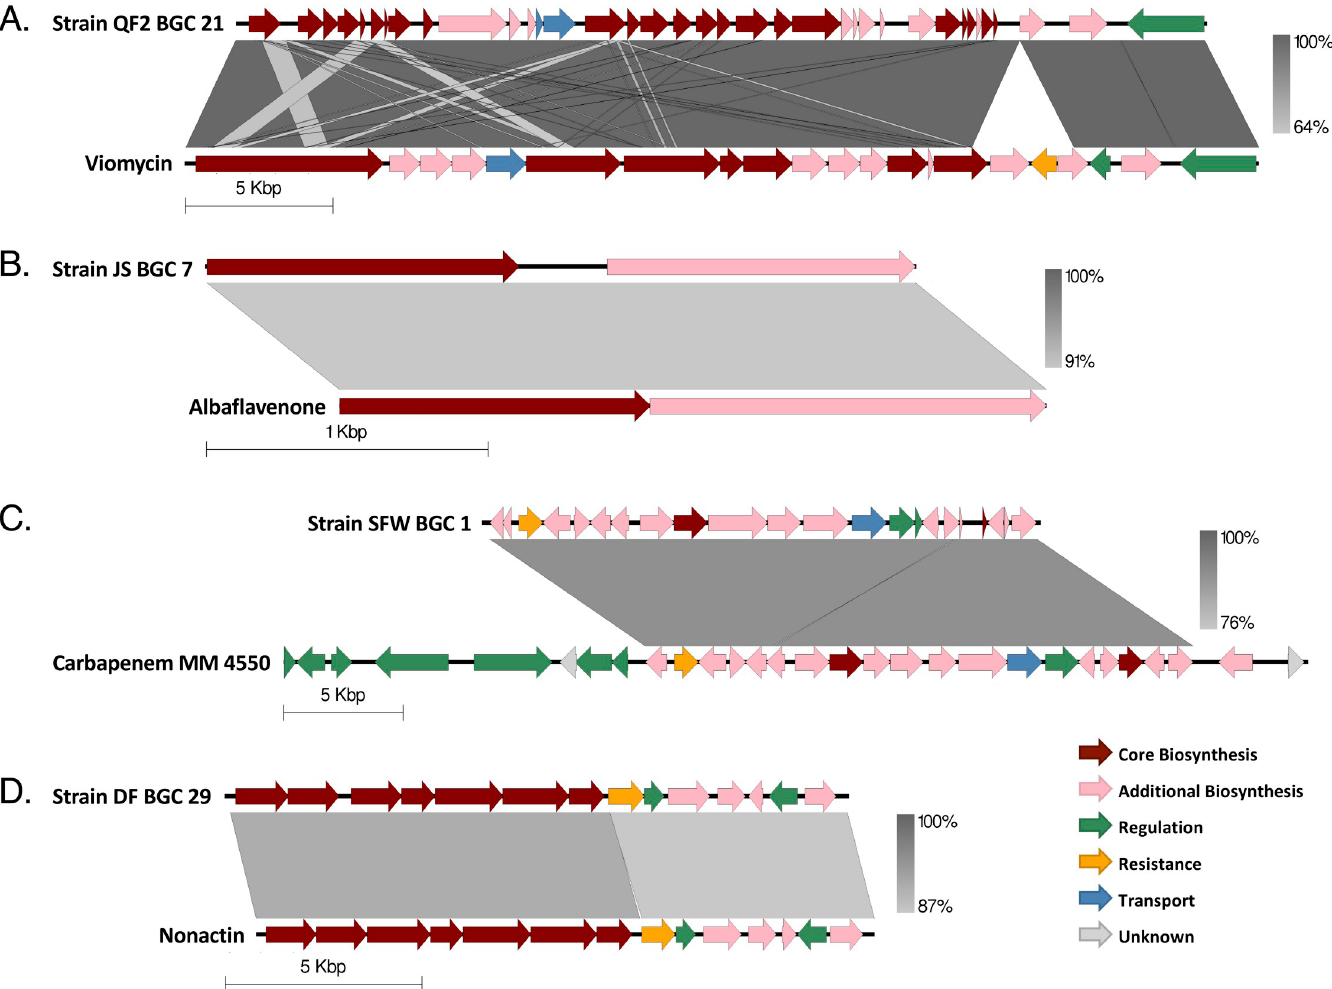
Fig 5. Comparison of BGCs encoded in the genomes of bacterial soil isolates and the predicted most similar, previously characterized BGC with an antibacterial product. ( A ) Strain QF2, BGC 21, compared to the BGC previously described to produce the antibiotic viomycin (NCBI Acc No. AY263398.1), encoded in the WGS of S . vinaceus ATCC 11861. ( B ) Strain JS, BGC 7, compared to the BGC previously described to produce the antibacterial sesquiterpene Albaflavenone (NCBI Acc No. AL645882.2), encoded in the WGS of S . coelicolor A3(2). ( C ) Strain SFW, BGC 1, compared to the BGC previously described to produce the antibacterial beta-lactam Carbapenem MM 4550 (NCBI Acc No. KF042303.1), encoded in the WGS of S . argenteolus ATCC 11009. ( D ) Strain DF, BGC 29, compared to the BGC previously described to produce the ammonium ionophore antibiotic Nonactin (NCBI Acc No. AF074603.2), encoded in the WGS of S . griseus subsp . griseus ETH A7796. Cluster comparisons were constructed in Easyfig. Regions of nucleotide homology are indicated on a gray scale and genes are colored according to the putative function of the corresponding protein